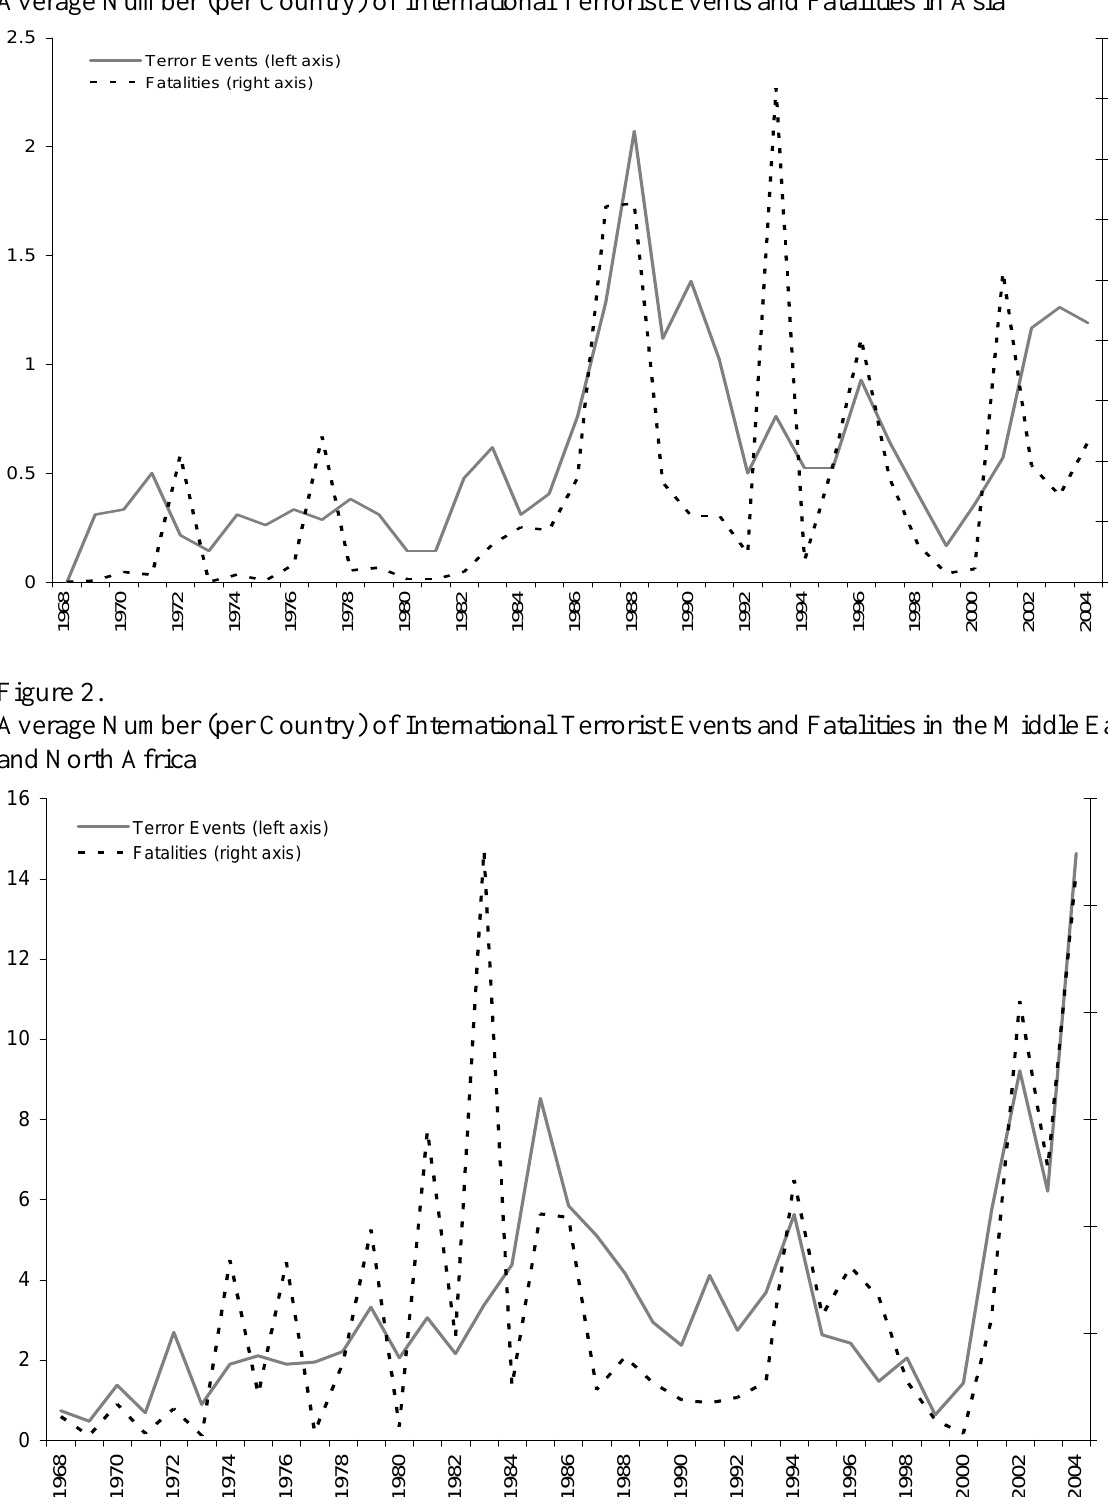
Average Number (per Country) of International Terrorist Events and Fatalities in Asia